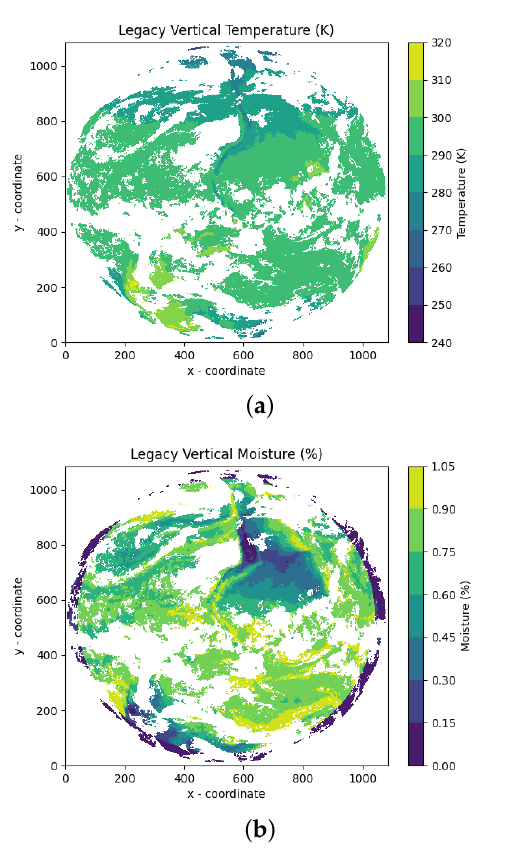
Figure 4. Pressure level 1 plots of model imagery data on 2 July 2021 at 00:00:00 GMT. ( a ) Temperature (K) ( b ) Moisture